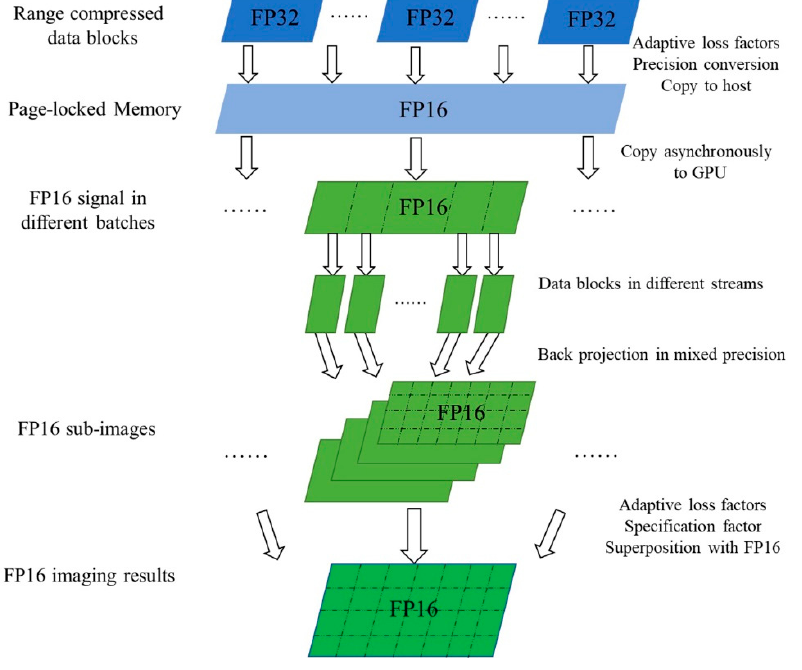
Figure 7. Streaming BP algorithm with FP16.